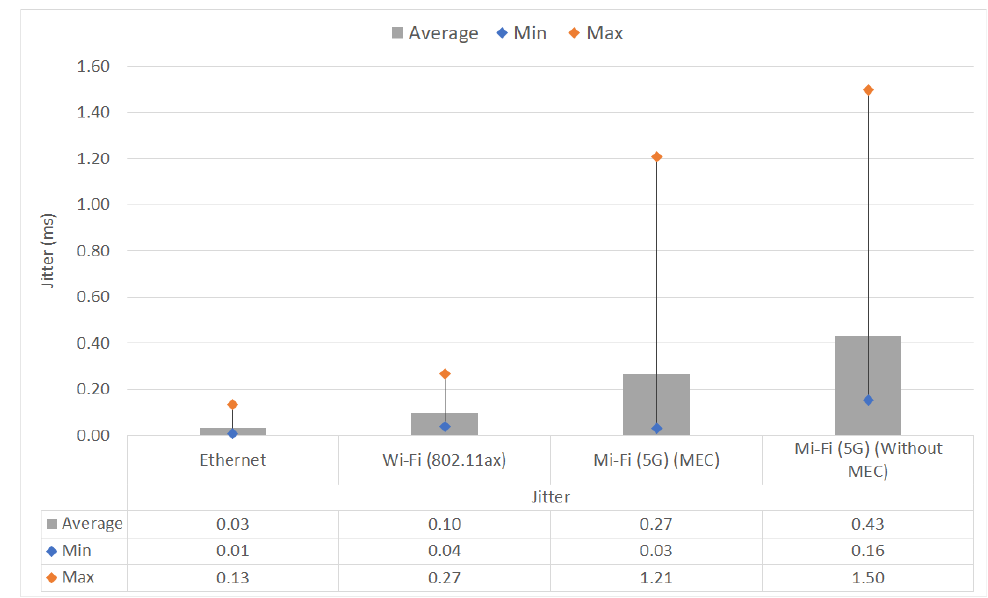
Figure 7. Multi-Access Edge Network Latency.